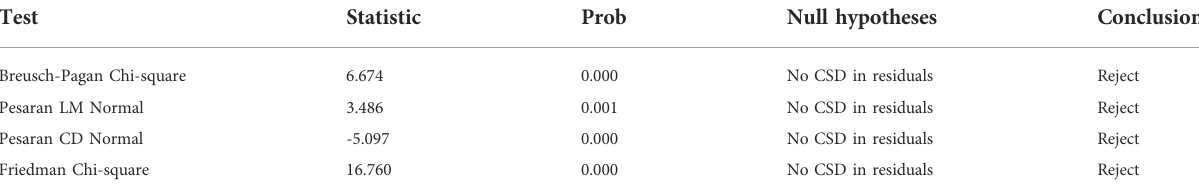
TABLE 2 Test of residual cross-section dependence.